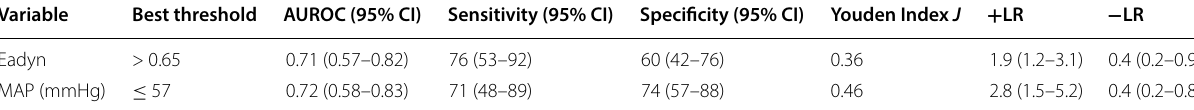
The best threshold value was determined using Youden